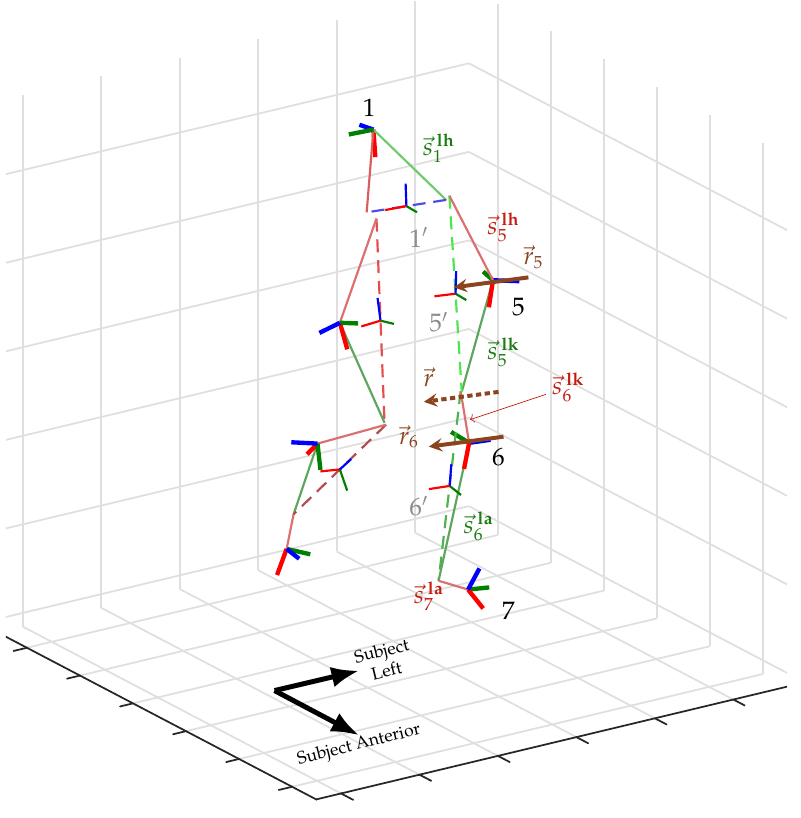
Figure 1. The human-IMU kinematic system, with the subject mid-stride. Image is an excerpt frame from a 3D animation using the proposed method. The subject’s left leg is labeled with coordinate systems of the IMUs (bold RGB triplets with black text label) and anatomical segments (thin RGB triplets with gray text label), the static vectors from the IMUs to neighboring joint centers (red and green), and the knee’s hinge axis (dotted brown) with their static representations in the thigh and shank IMU frames (solid brown). Notation of variables is detailed in Section